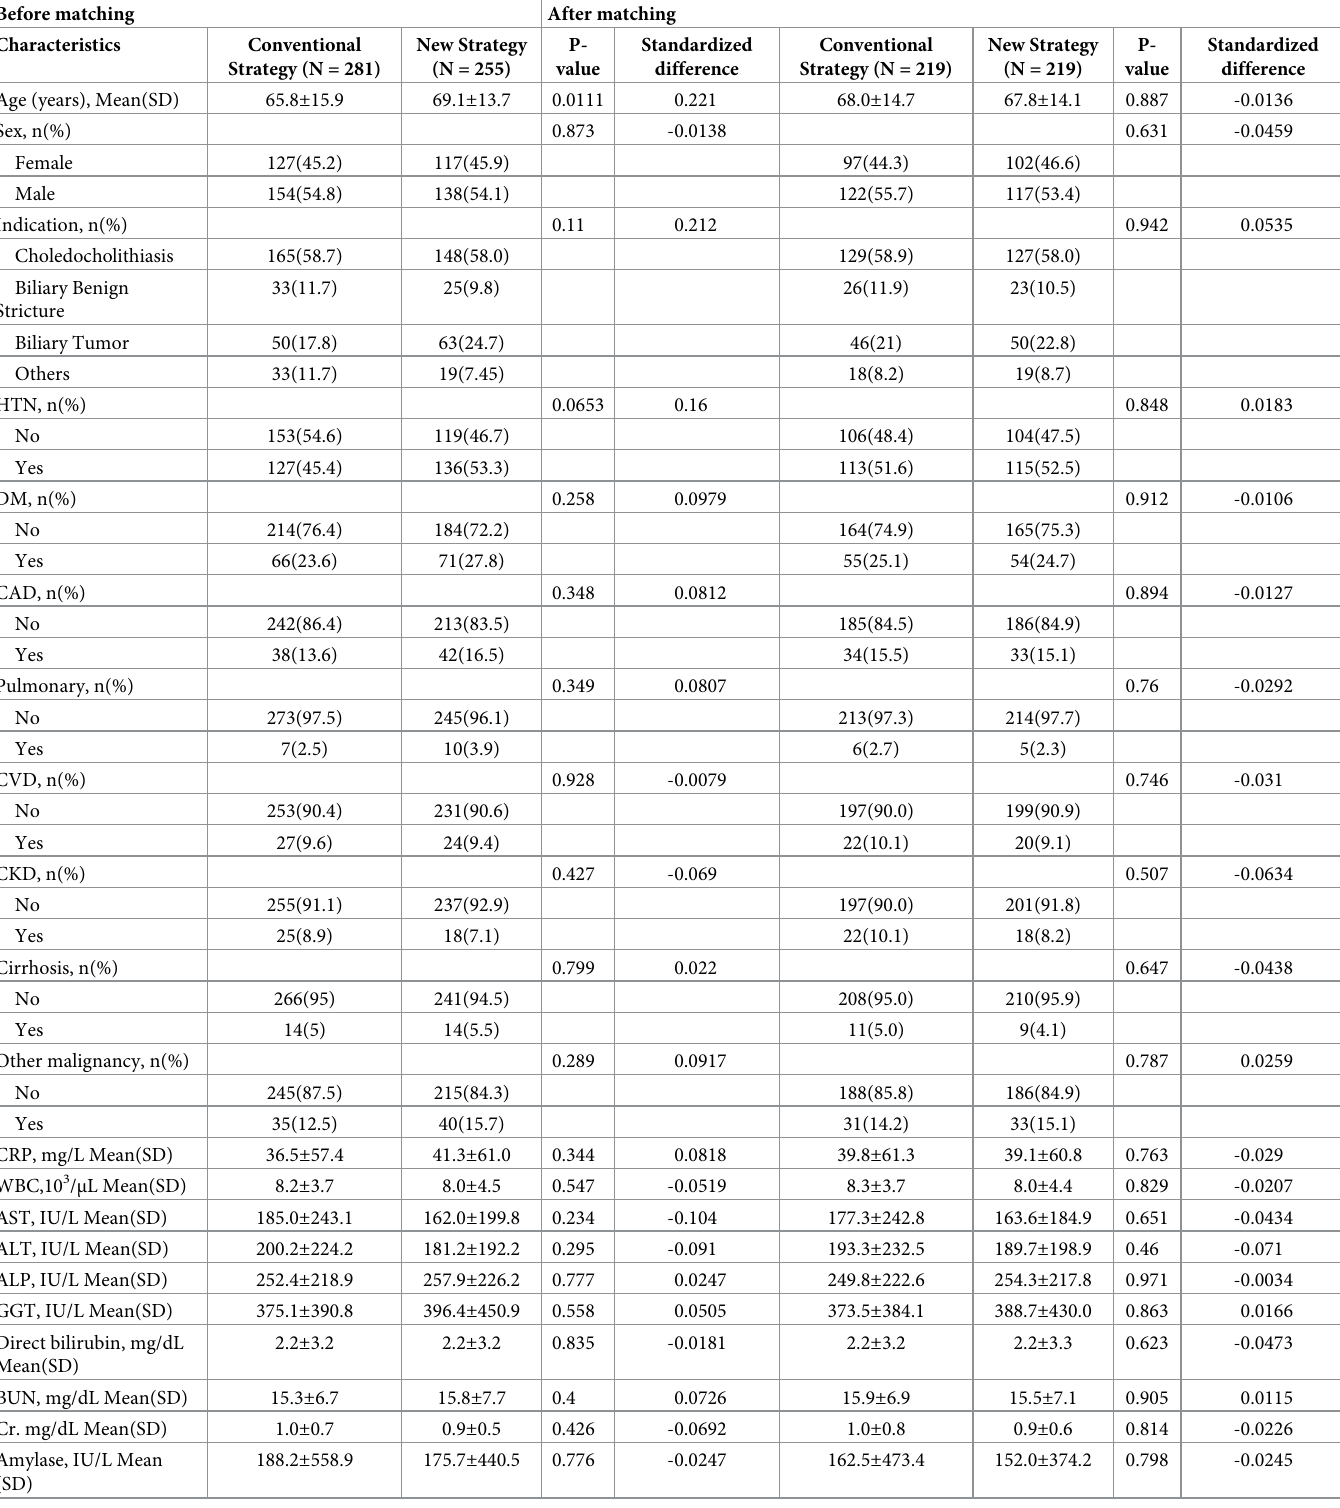
Table 1. Baseline characteristics of the conventional and new strategy groups with patients with ERCP cannulated before and after propensity score matching. Before